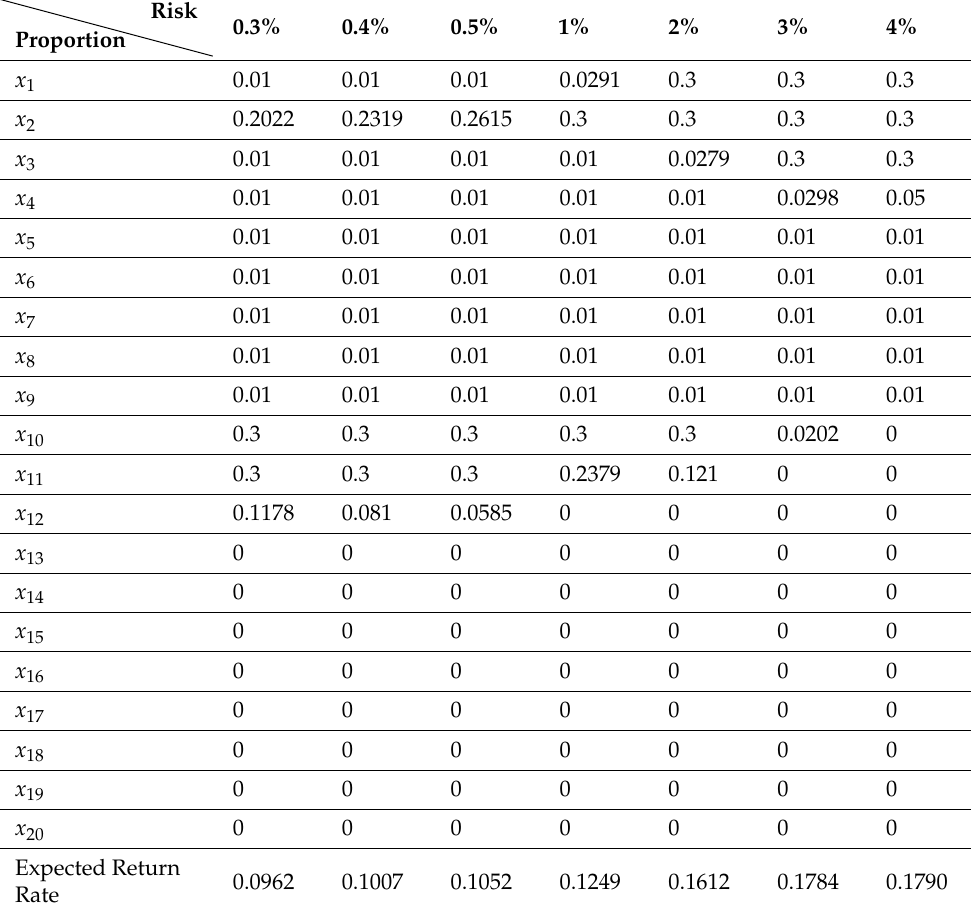
Table 7. The efficient portfolio with the guaranteed return rate (cid:101) p 2